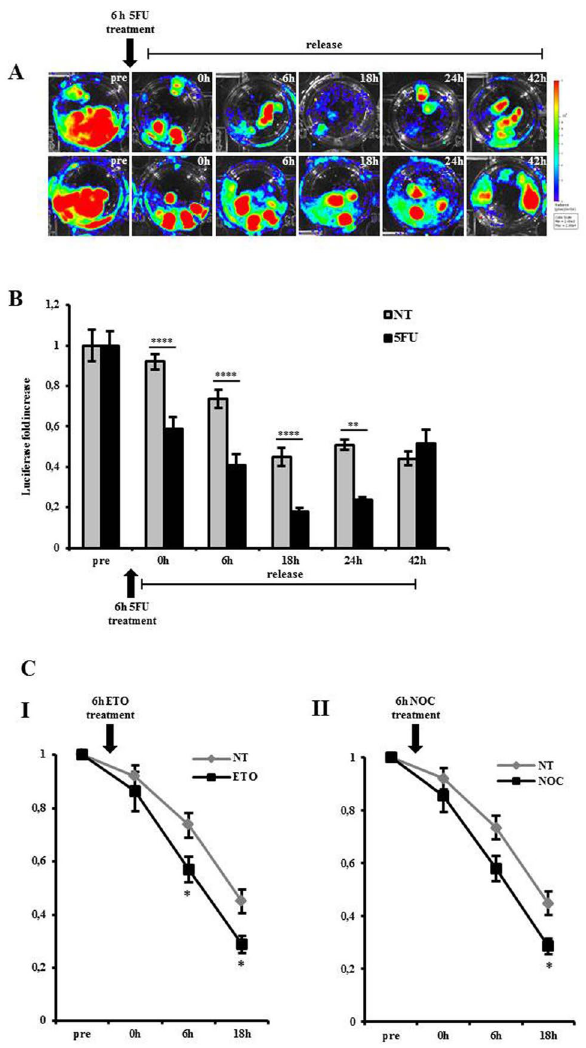
Figure 6. Inhibition of luciferase in zebrafish embryos upon antiproliferative treatments. ( A ) BLI of a pool of 10 MITO-Luc/GFP embryos before treatment (pre). The embryos have been treated with a pulse of 100 mM 5FU for 6 h as indicated. Upon 5FU washout and replacement with fresh water BLI was measured at time 0, 6, 18, 24 and 42 h. Bottom panel represent untreated control group imaged at the same time points. ( B ) Relative luciferase activity of a pool of 10 MITO-Luc/GFP embryo extracts collected before treatment. The embryos were treated with a pulse of 100 mM 5FU as indicated. Following 5FU washout and replacement with fresh water embryo extracts were collected at time 0, 6, 18, 24 and 42 h. Gray bars represent untreated control pool extracts collected at the same time points. The error bars are mean standard deviations from three experiments performed in triplicate. Asterisks denote significant differences between control and treated groups assessed by t-test (***p < 0.001****p < 0.0001). ( C ) Relative luciferase activity of a pool of 10 MITO-Luc/GFP embryo extracts. The embryos were treated with a pulse of 20 mM Etoposide (I) and 150 nM Nocodazole (II) for 6 h as indicated. Upon drug removal and replacement with fresh water embryo extracts were collected at time 0, 6, 18 h. Gray lines represent untreated control pool extracts collected at the same time points. The error bars are mean standard deviations from three experiments. Asterisks denote significant differences between control and treated groups assessed by t-test (*p <